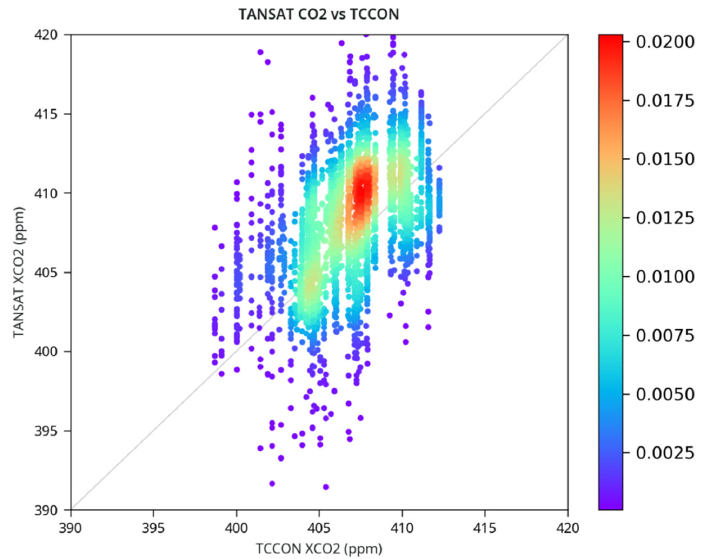
Figure 2. Validation of overall XCO 2 retrieved from TanSat nadir measurements over land with collocated TCCON data after bias correction. For retrievals collocated with multiple TCCON stations, we use data from the closest station. Different colors represent the normalized frequency of occurrence.